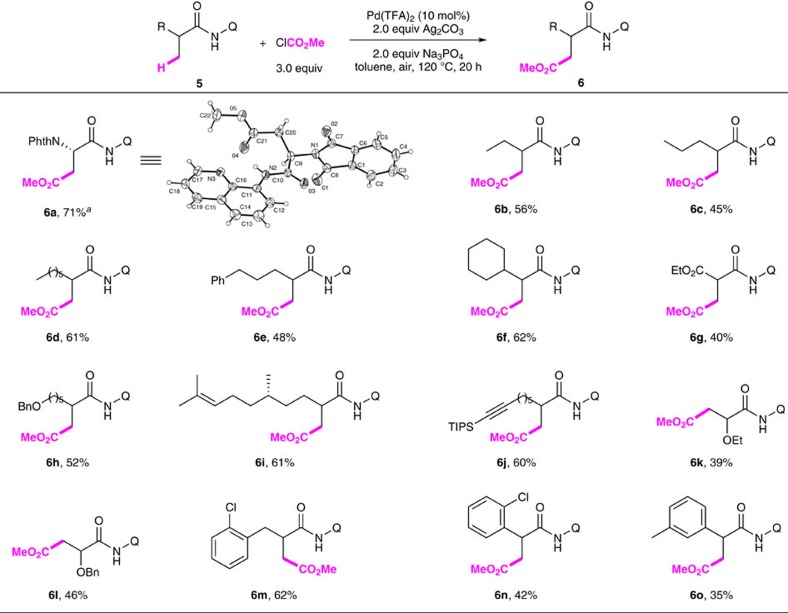
Pd-catalysed alkoxycarbonylation of β-Methylene C(sp3)–H Bonds.Reaction conditions: 5 (0.15 mmol), Pd(TFA)2 (10 mol%), Ag2CO3 (2.0 equiv.), Na3PO4 (1.0 equiv.), ClCO2Me (3.0 equiv.), toluene (1.5 ml), 120 °C, air, 20 h. Isolated yield. aIn the absence of Na3PO4.